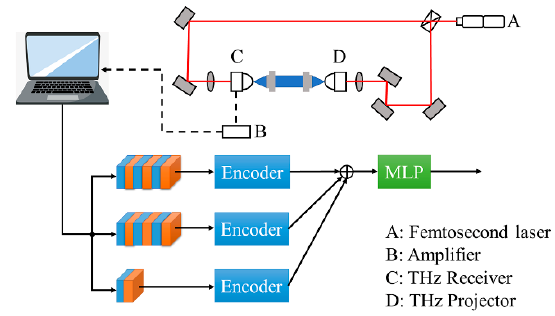
Figure 7. The experimental system.